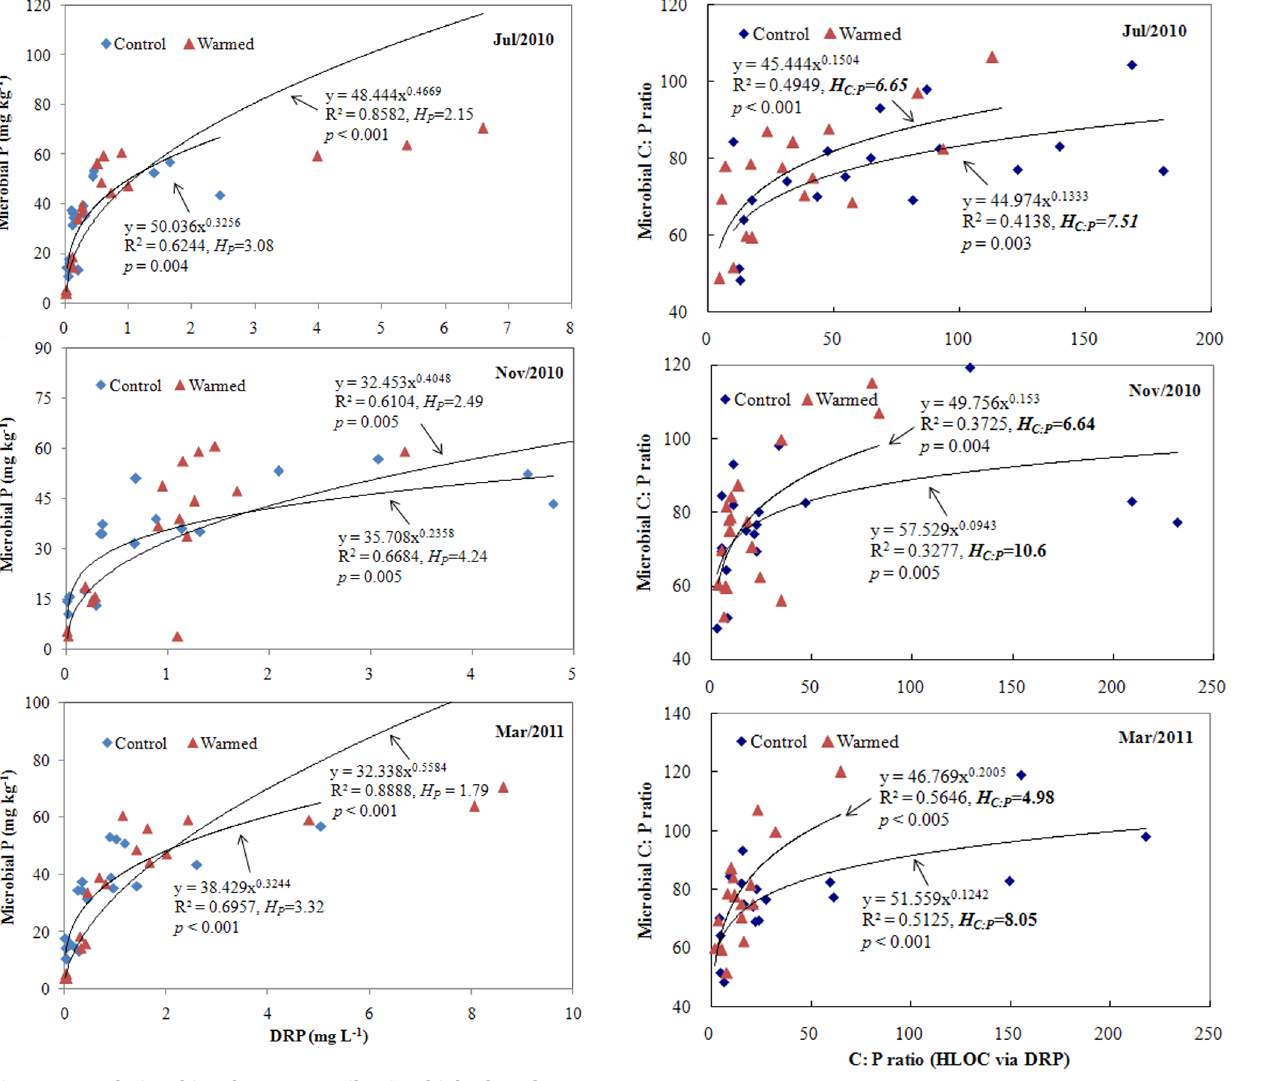
Figure 3. Relationships between the molar ratios of carbon to phosphorus (C:P) in soil microbial biomass and the C:P ratios of soil highly labile organic carbon (HLOC) to dissolved reactive phosphorus (DRP) in porewater. Control and Warmed represent treatments of ambient temperature and ambient tempera- ture + 5 u C, respectively. Coefficients fitting the data to the equation for stoichiometric homeostasis are given along with an estimate of H C:P .